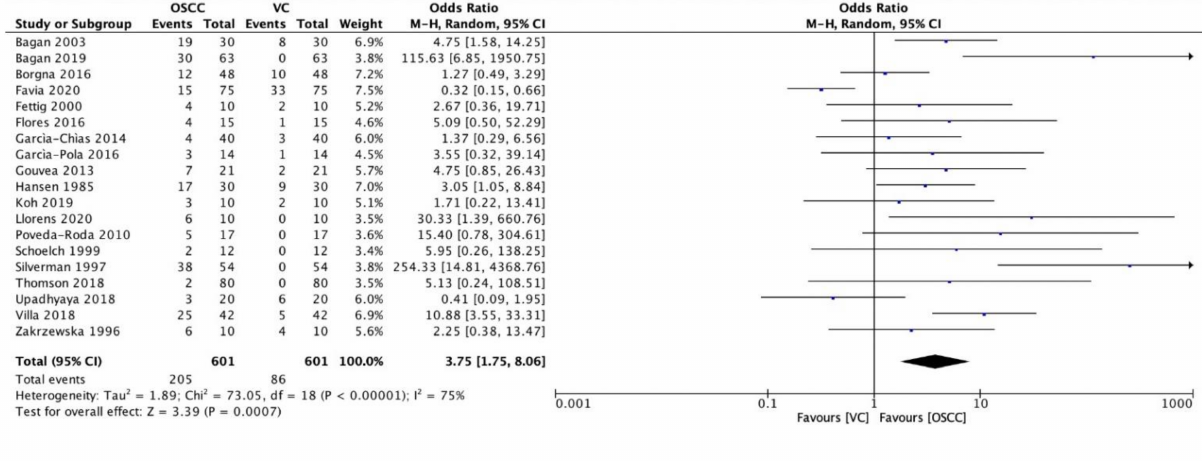
Figure 3. Forest plot relating to the distribution of conventional oral squamous cell carcinomas (OSCC) and verrucous carcinomas (VC) among patients with PVL.